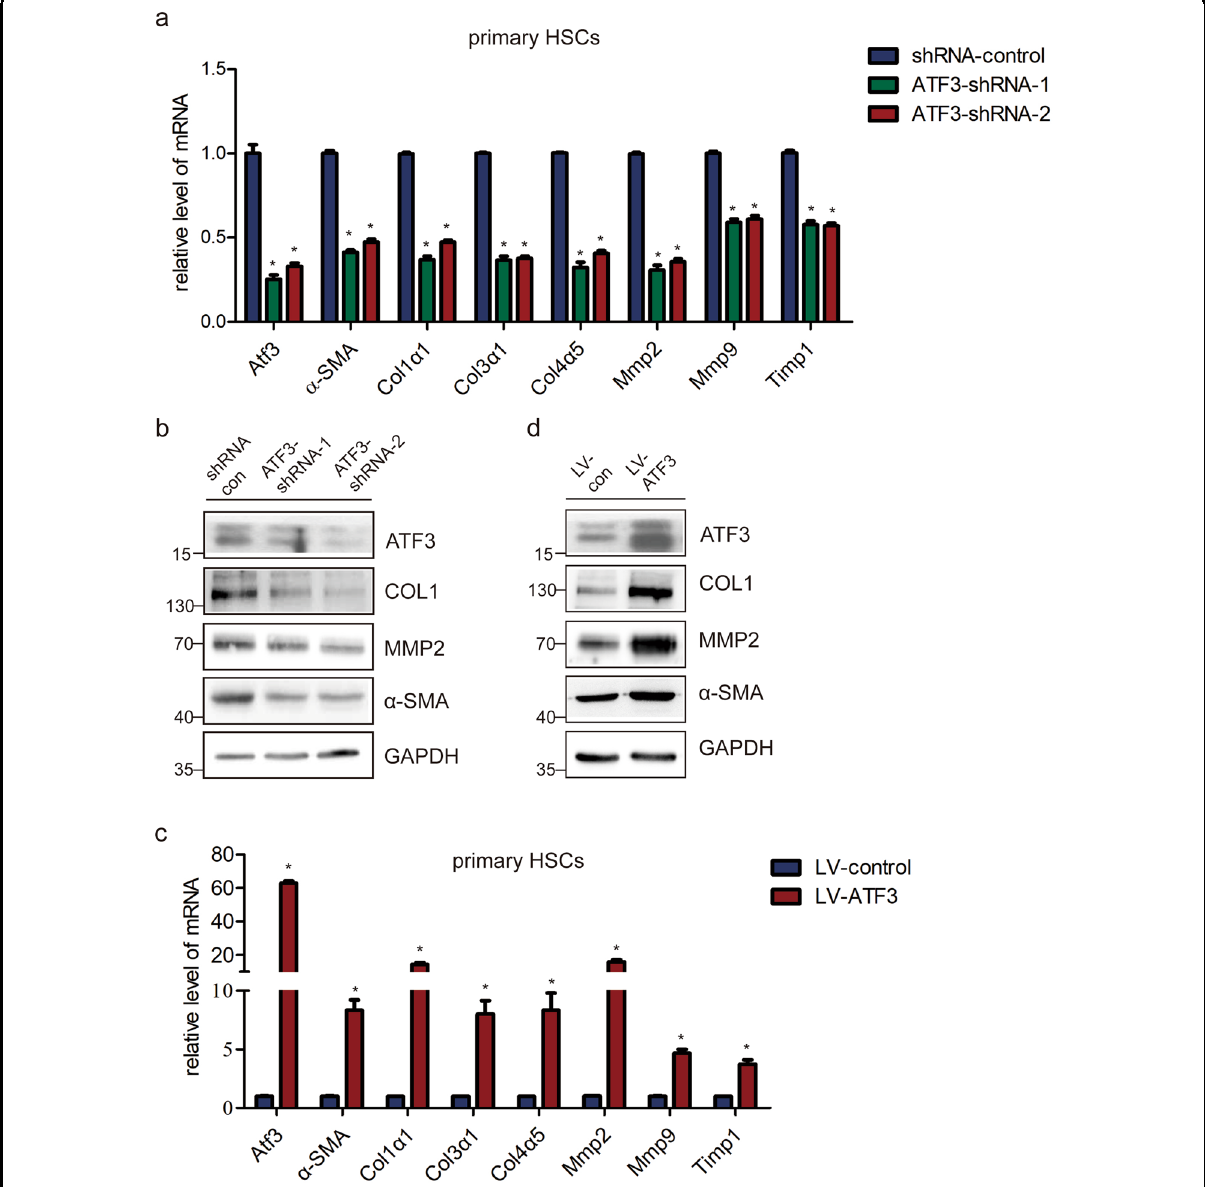
by western blot. GAPDH was used as an internal control. c The mRNA level of α -SMA , Col1 α 1 , Col3 α 1 , Col4 α 5 , Mmp2, Mmp9 , and Timp1 were detected in primary HSCs infected with lenti-ATF3 or lenti-control by qRT-PCR; * p < 0.05. d The protein level of α -SMA, COL1, and MMP2 were detected in ATF3 upregulated primary HSCs by western blot. GAPDH was used as an internal control. The data were expressed as the mean ± SEM for at least triplicate